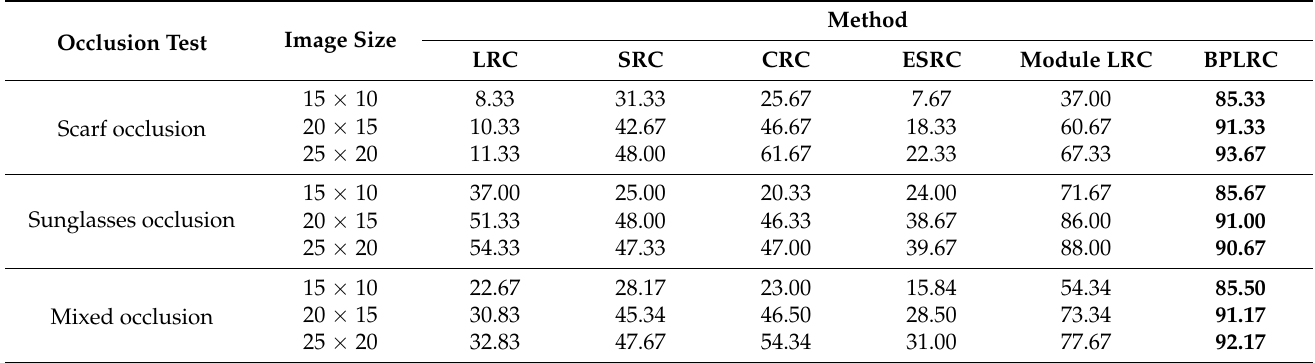
Table 1. Accuracy (%) of different methods when identifying scarf occlusion, sunglasses occlusion, and mixed occlusion images.